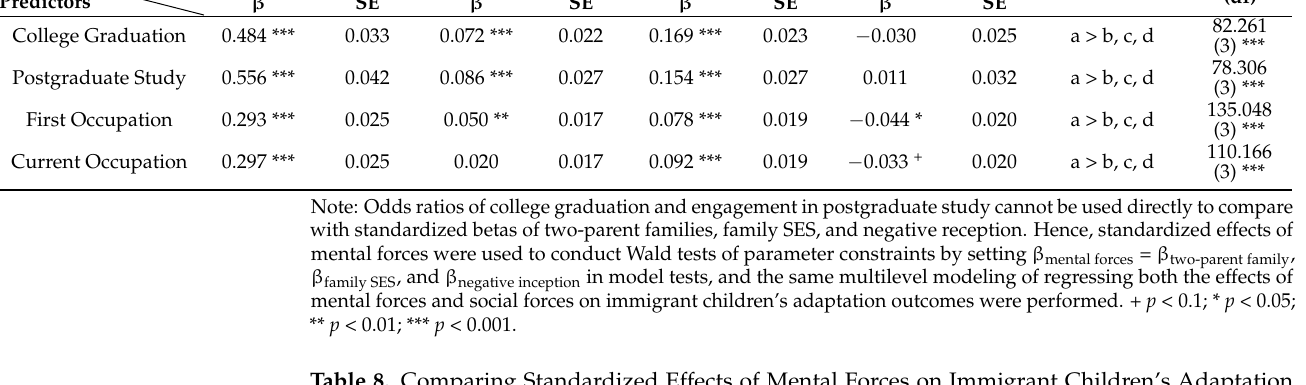
Table 8. Comparing Standardized Effects of Mental Forces on Immigrant Children’s Adaptation Outcomes across the Contexts of Family Composition, Family SES and Incorporation Mode from Multilevel